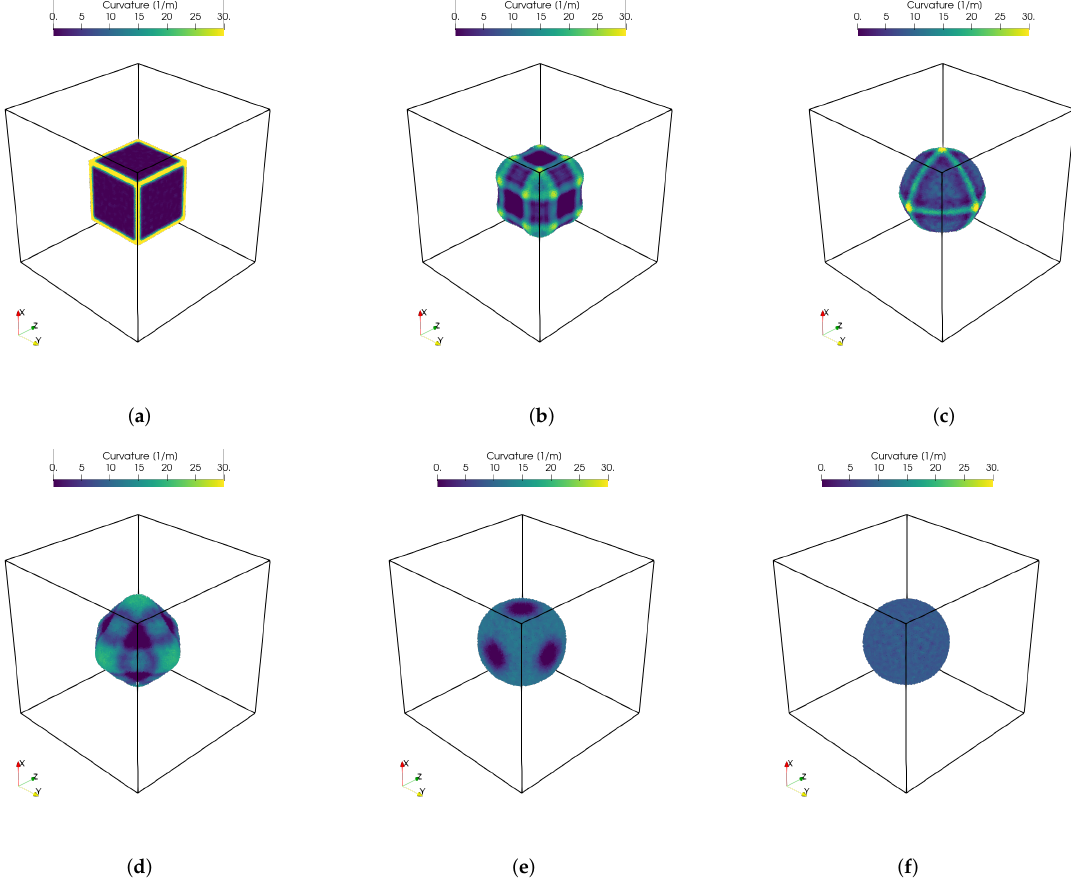
Figure 3. Droplet curvature for La = 1000 at ( a ) t = 0 s, ( b ) t = 0.015 s, ( c ) t = 0.030 s, ( d ) t = 0.045 s, ( e ) t = 0.100 s, and ( f ) t = 0.500 s.